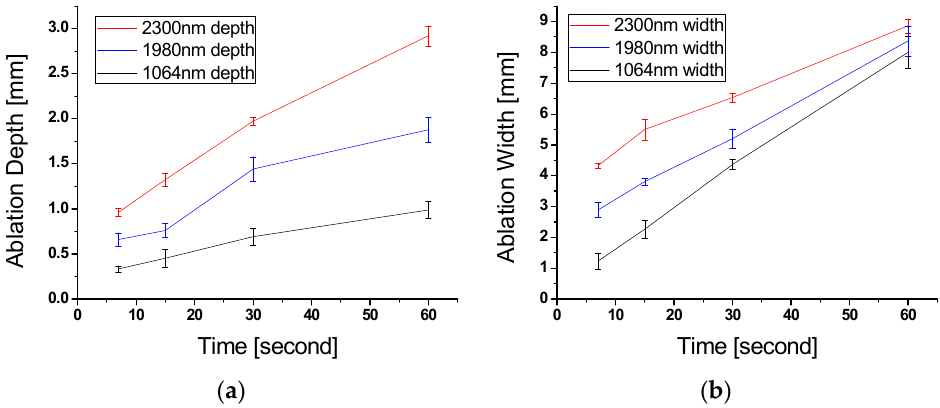
Figure 6. Ablation dimension measurement using OCT after laser irradiation at pump, signal, and idler wavelengths. Crater depths ( a ) and diameters ( b ) in millimeters versus laser irradiation time.